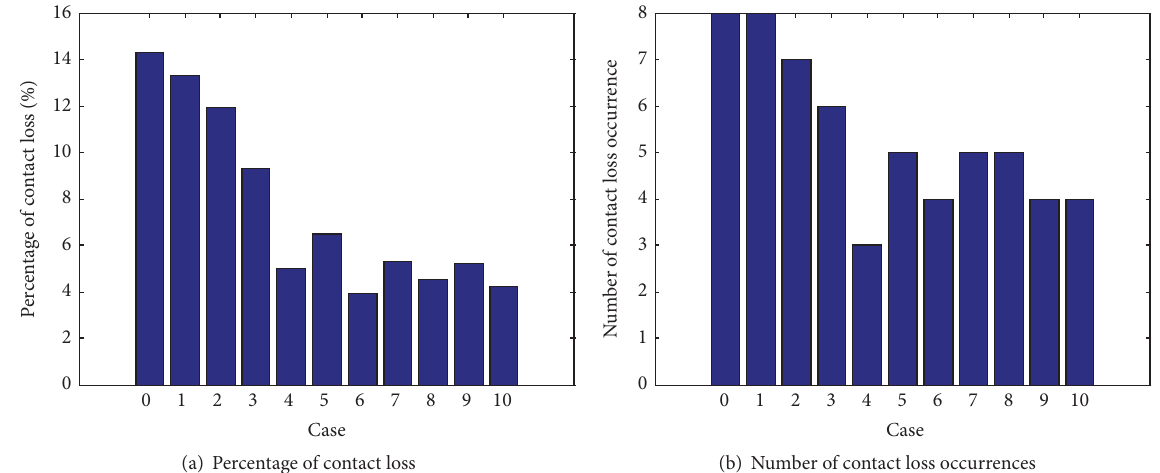
Figure 21: The results of Percentage of contact loss and number of contact loss occurrences.